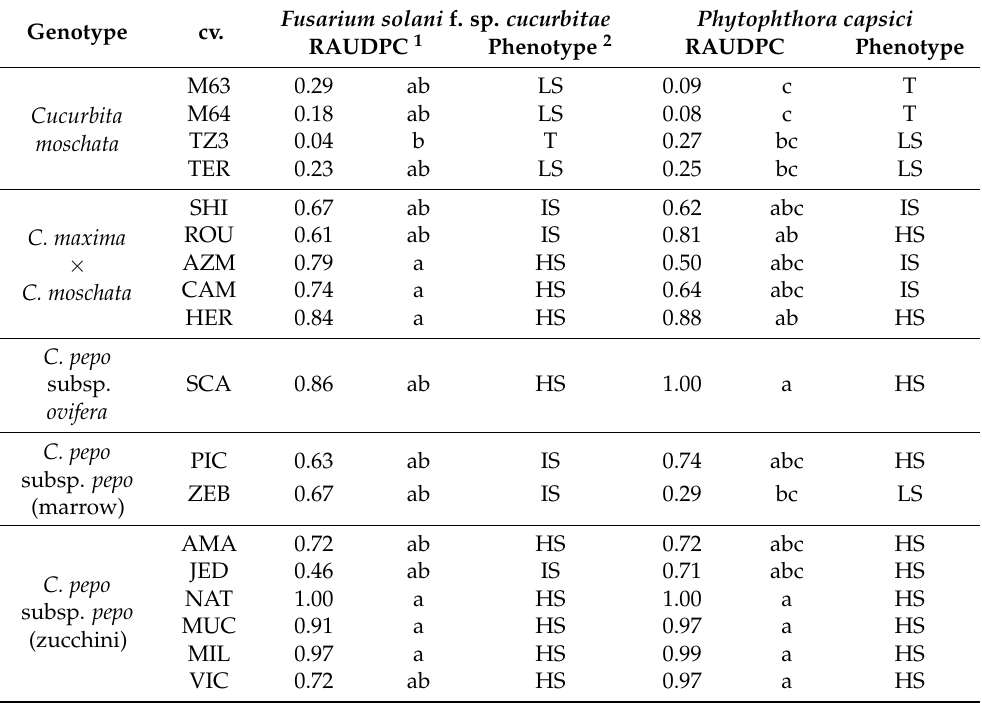
Table 2. Cucurbita spp. genotype responses to Phytophthora capsici and Fusarium solani f. sp. cucurbitae .